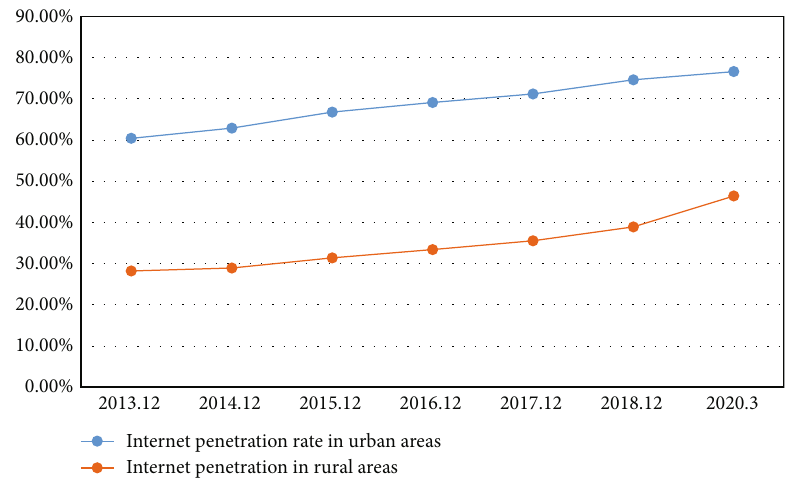
Figure 6: Scale of Internet users and Internet penetration rate in my country from 2013 to 2020.